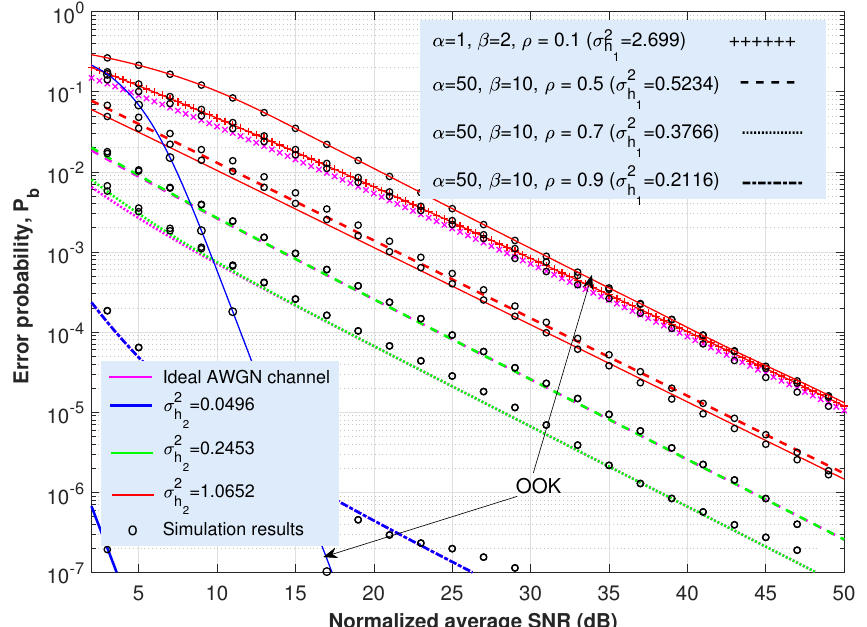
Figure 5. Analytical ABER and Monte Carlo simulation results (circles) vs. SINR γ 0 for an OOK-GScc = 0.0496), weak-to-moderate ( σ 2 = 0.2453) and format with a code rate of 1/8 under weak ( σ 2 h 2 h 2 = 1.0652) salinity induced turbulence and different Málaga turbulence intensities in the strong ( σ 2 h 2 terrestrial FSO link. Scenarios and values of irradiance variances in the underwater medium taken from acquired data presented in [68]. In solid lines, the performance of the system when only oceanic turbulence is considered is